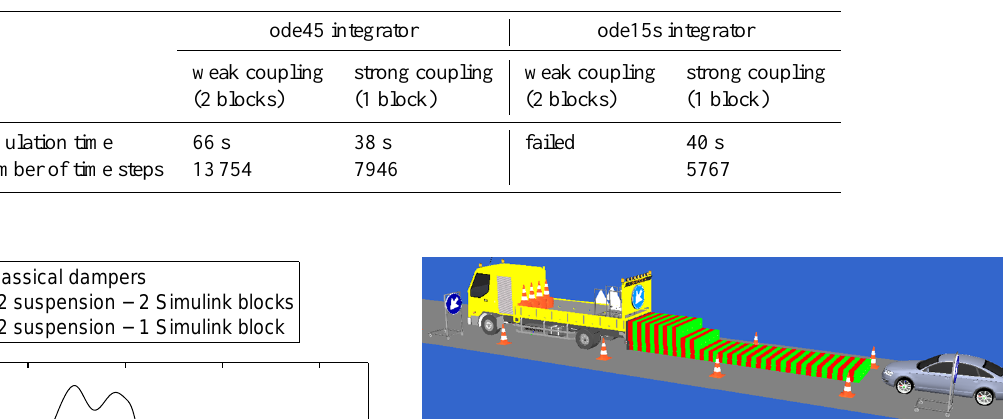
Figure 16. Illustration of the two approaches for coupling the hydraulic and mechanical models. Left: weak coupling using two separated blocks. Right: strong coupling using one monolithic block. Table 1. Calculation performance for the line change manoeuvre simulation of the model of the Audi A6 equipped with the Kinetic H2 suspension. The simulation was performed on a computer running with Windows 7 and equipped with an Intel Core 2 Duo CPU (2.53GHz), 4 GB RAM.